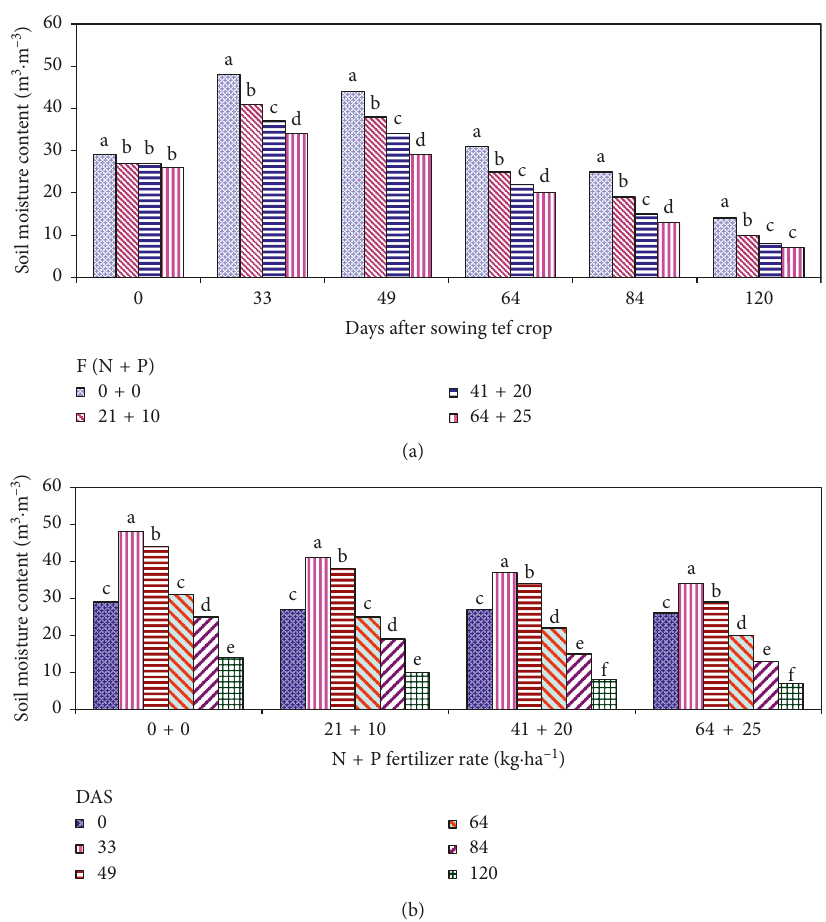
Figure 3: Soil moisture content in the 2013 cropping season as affected by (a) fertilizer rates in a given sampling date and (b) growth stages (sampling dates) for the same fertilizer rate. Note: F (N+P) denotes fertilizer N plus P (kg · ha − 1 ) as 0 N+0 P (F1), 21 N +10 P (F2), 41 N +20 P (F3), and 64 N +25 P (F4); DAS, days after sowing, refers to the soil sampling date to determine